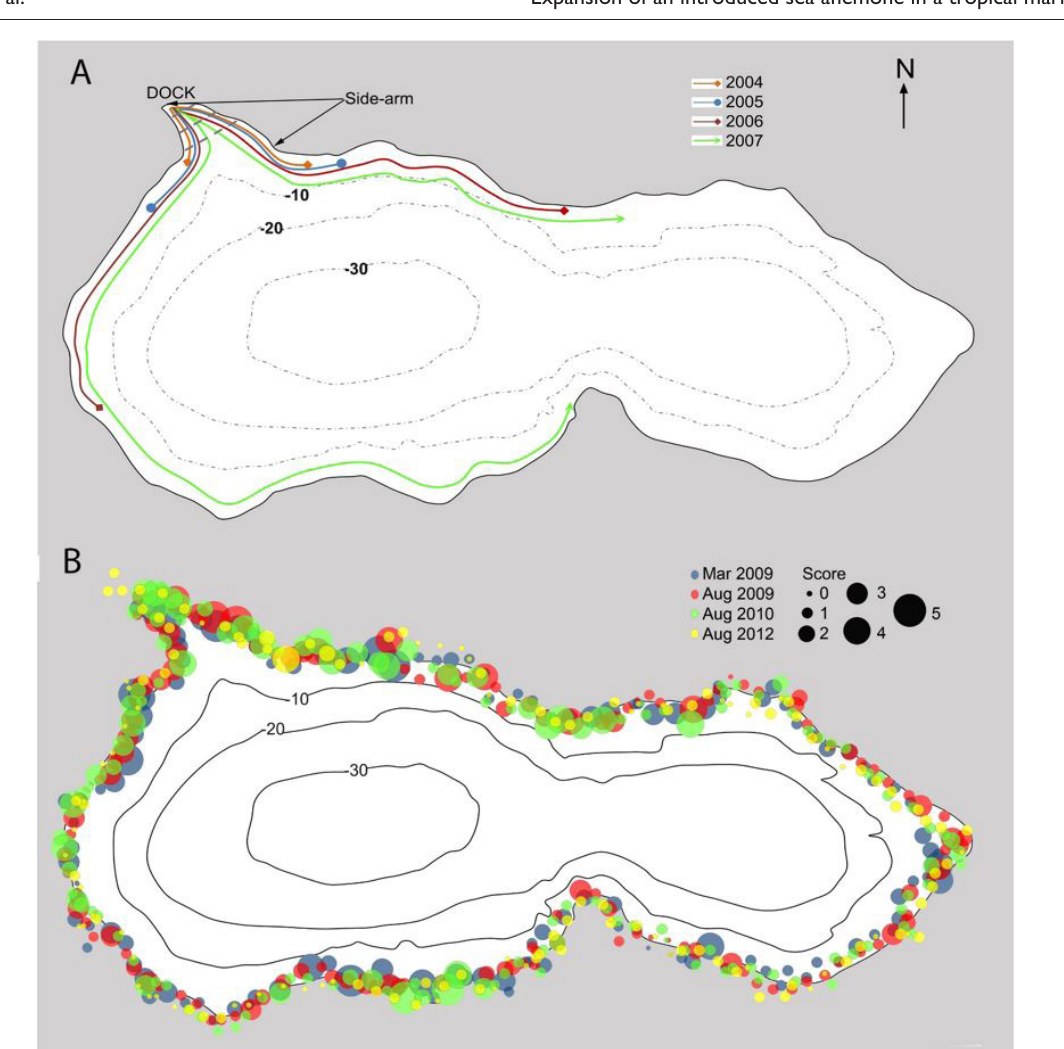
Figure 4. Continued expansion of Exaiptasia pallida in Jellyfish Lake from 2003–2012. (A) Colored lines represent the expansion of E. pallida , from the original 2003 location in the side–arm near the tourist dock (marked in NW corner) to the farthest extent in each of the subsequent years, 2004–2007. Dashed grey lines near dock located within side-arm represent location of Transect 1, 4, and 8; subsequent transects (T2-T7, not pictured) are spaced at 6m intervals between T1 and T8. (B) Bubble plots indicating the distribution and abundance of E. pallida from 2009–2012, with different colors representing different survey dates. Bubble sizes are proportional to the scoring of sites based on 20% cover intervals of E. pallida (i.e., 0 is for no E. pallida , 1 is for 20% cover, 2 is for 40% cover, and so on). Line and bubble plots are superimposed on a bathymetric map of the lake with contour lines at depths of 10 m, 20 m, and 30